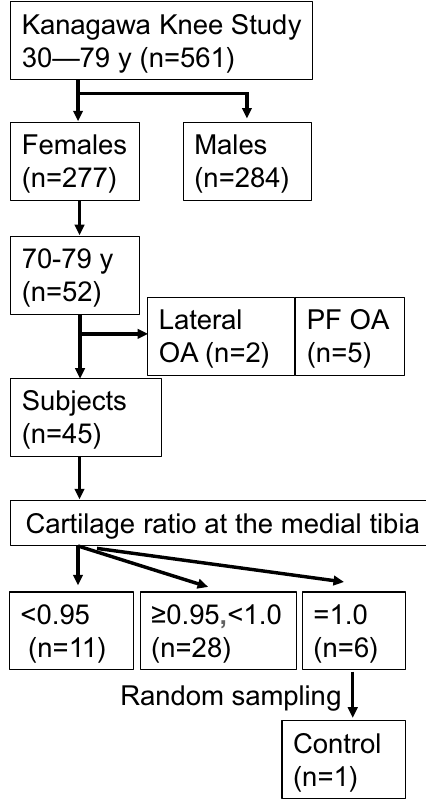
Figure 2. Enrollment of subjects. The Kanagawa Knee Study consisted of 561 subjects, including 277 females, 52 of whom were women 70–79 years old. Excluding 2 subjects with lateral osteoarthritis (OA) and 5 subjects with patellofemoral (PF) OA, 45 subjects were selected for analysis in this study; 11 of these subjects had cartilage area ratios at the medial tibial < 0.95. One control subject was randomly selected from 6 subjects with cartilage area ratios of